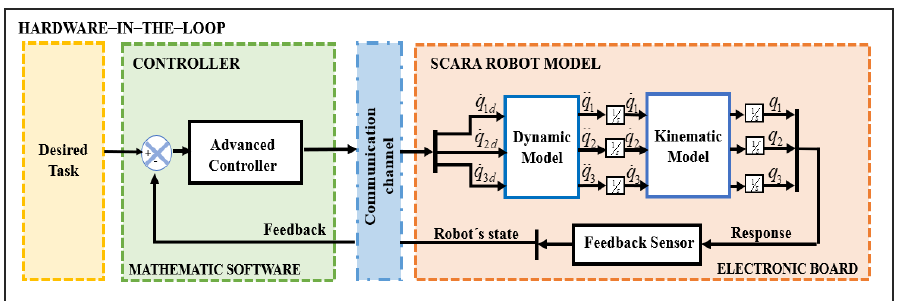
Figure 1. Hardware – in – the – Loop (HIL) block diagram. Figure 1. Hardware–in–the–Loop (HIL) block diagram.